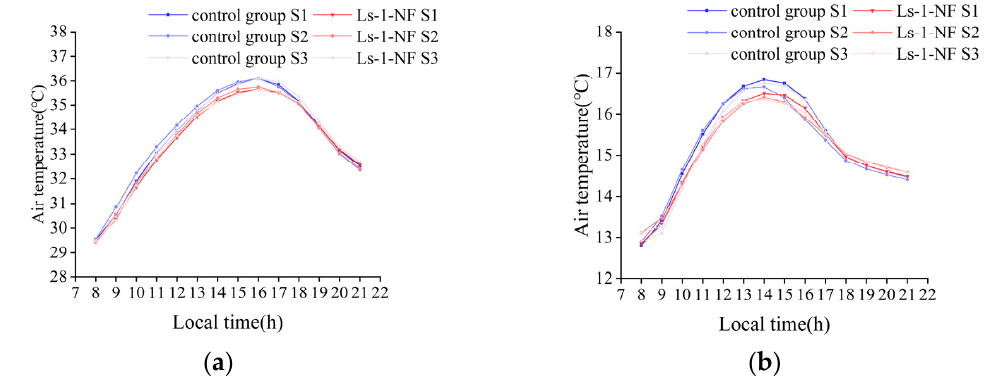
Figure 16. Effects of planting arbors on air temperature in different walking spaces in summer ( a ) and winter ( b ).